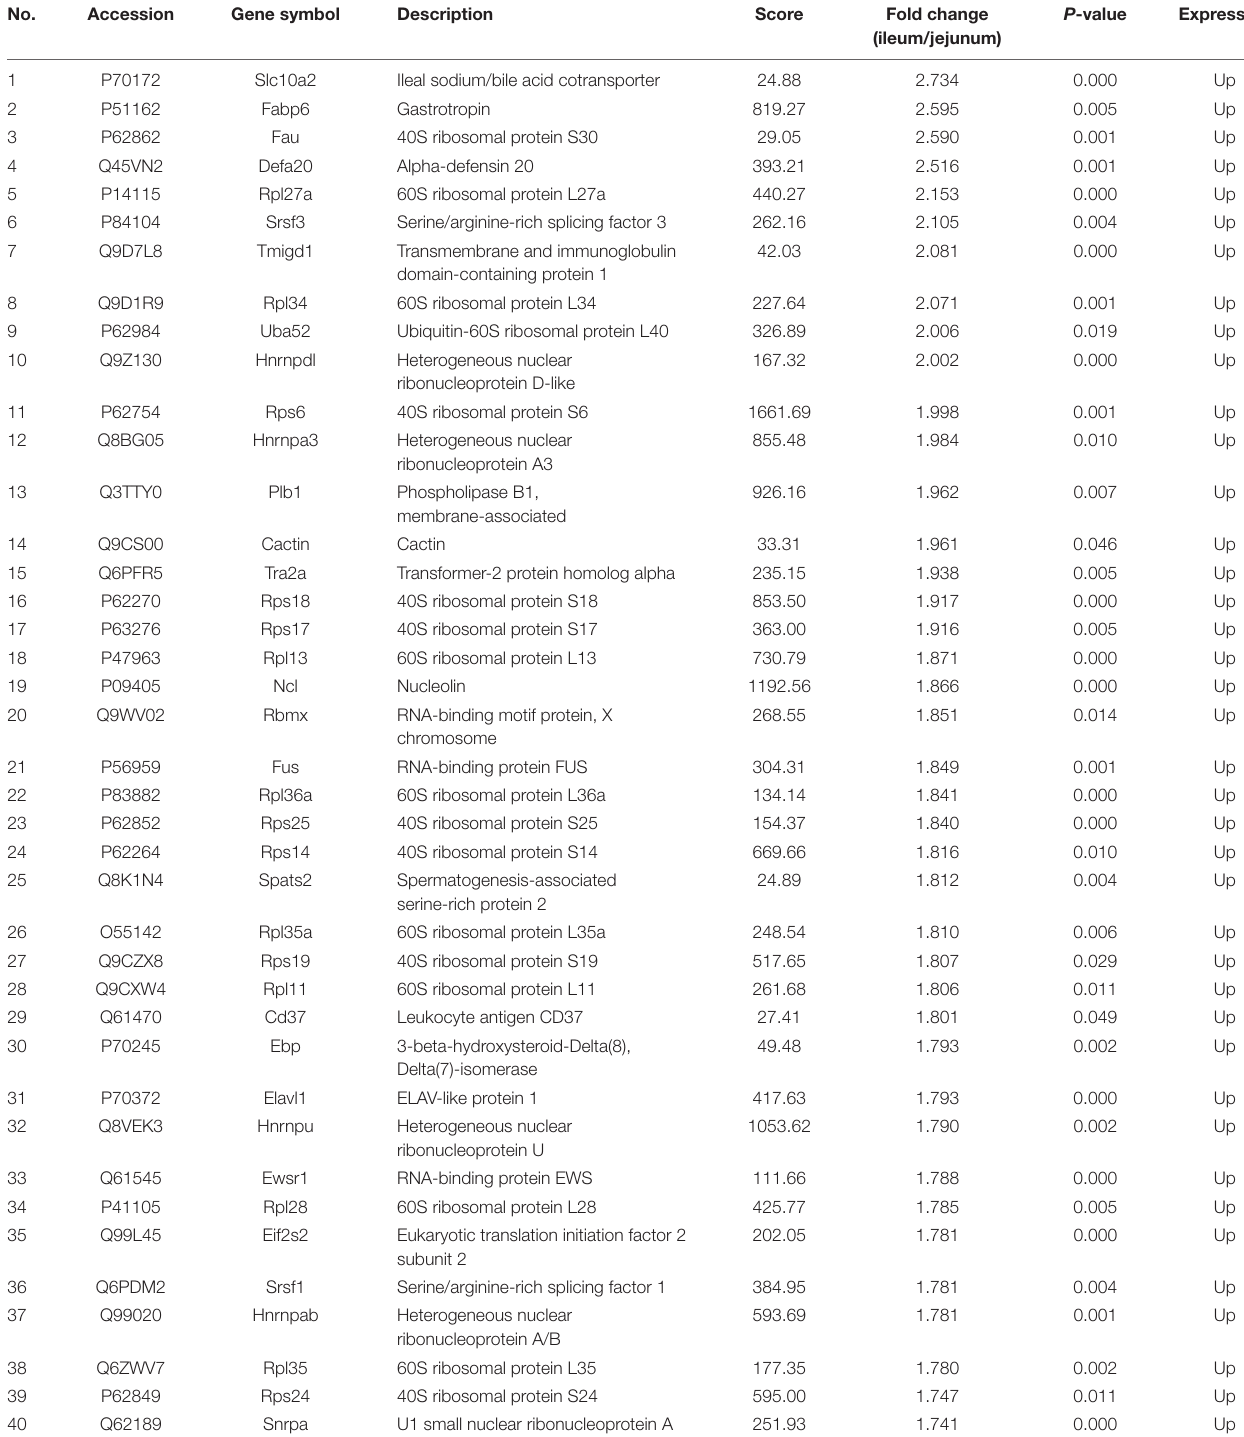
TABLE 1 | Top 40 up-regulated protein information.